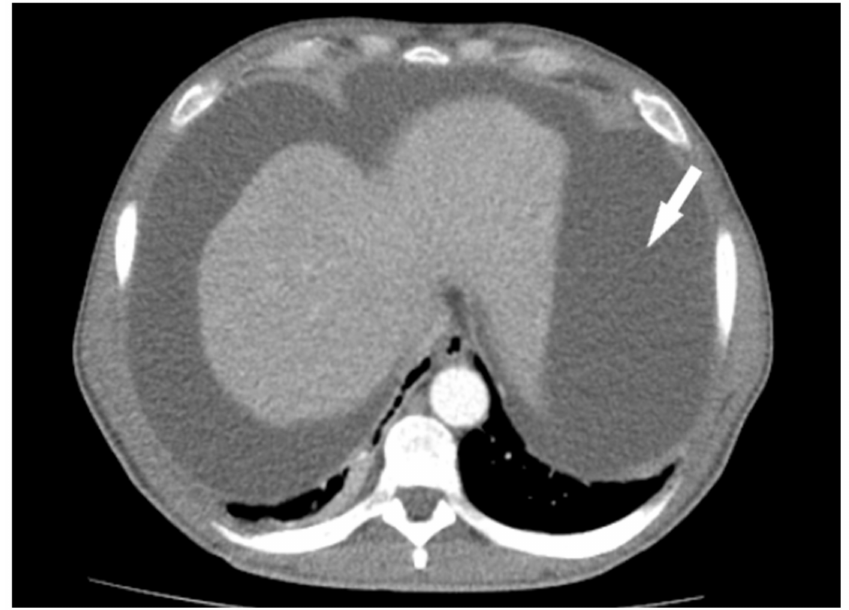
Figure 2. Tomographic image showing abundant fluid in the abdominal cavity: Signs of ascites (white